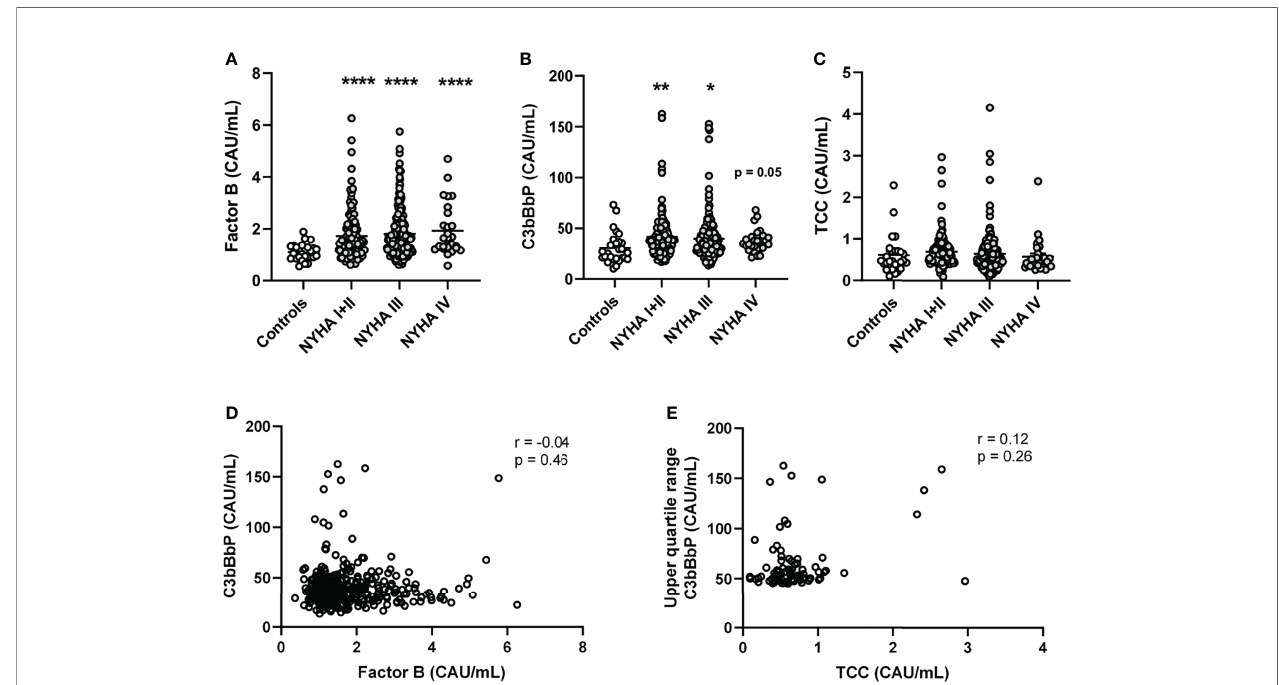
FIGURE 1 | Plasma levels of alternative complement pathway components Factor B and C3bBbP are increased in patients with heart failure and do not correlate. Plasma levels of (A) complement factor B (FB), (B) C3bBbP, and (C) TCC were measured in 343 heart failure patients and 27 controls. Correlation between plasma levels of (D) Factor B and C3bBbP, and (E) C3bBbP and TCC levels. NYHA, New York Heart Association functional class; TCC, terminal complement complex; Values are mean±SEM *p < 0.05, **p < 0.01,